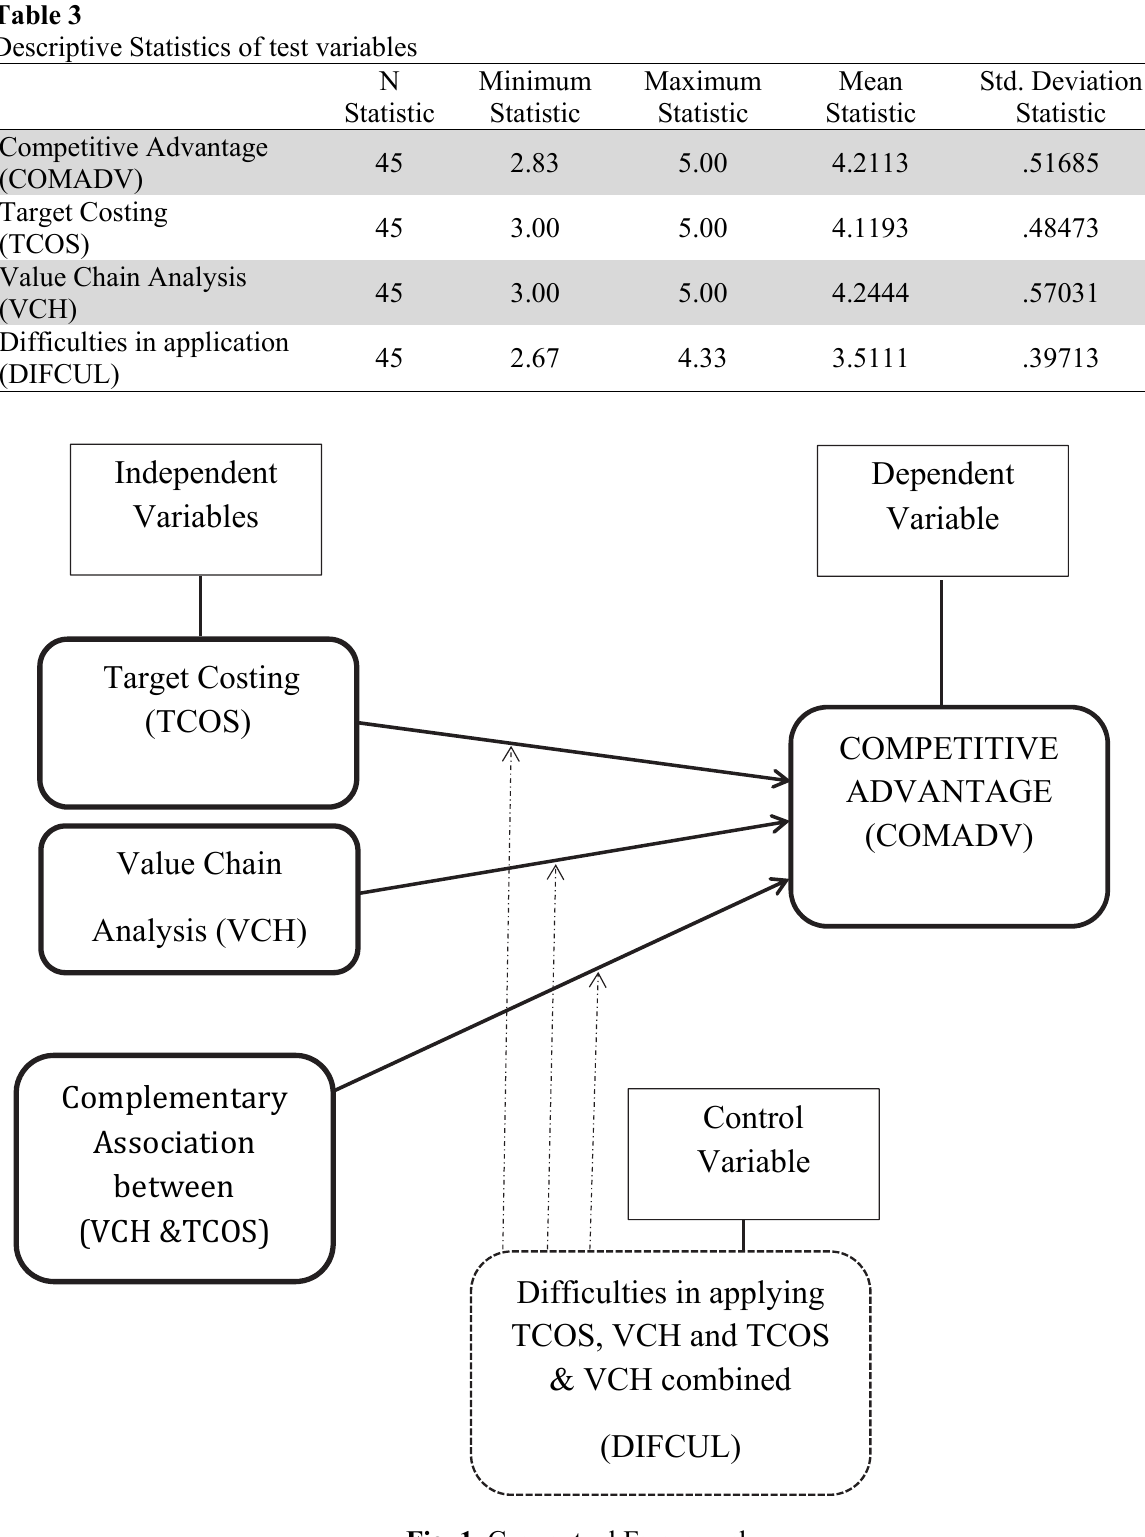
Fig. 1. Conceptual